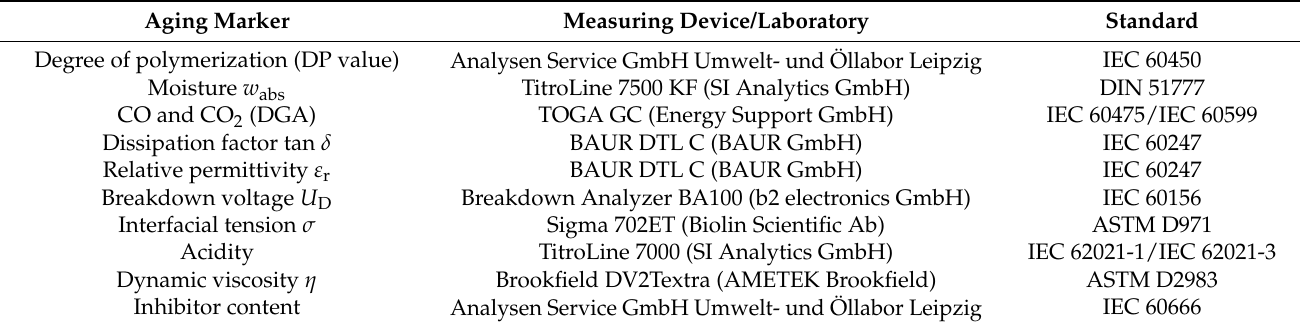
Table 2. Studied aging markers and related measurement devices and